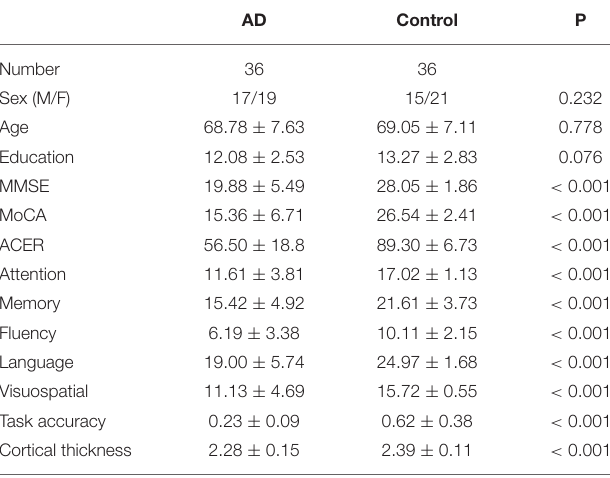
TABLE 1 | Demographic and clinical